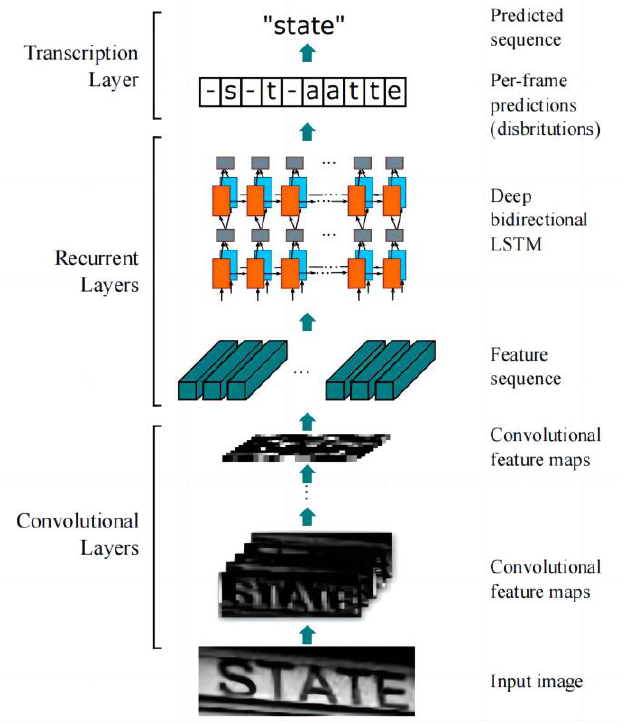
Figure 5. Flow diagram of CRNN algorithm.